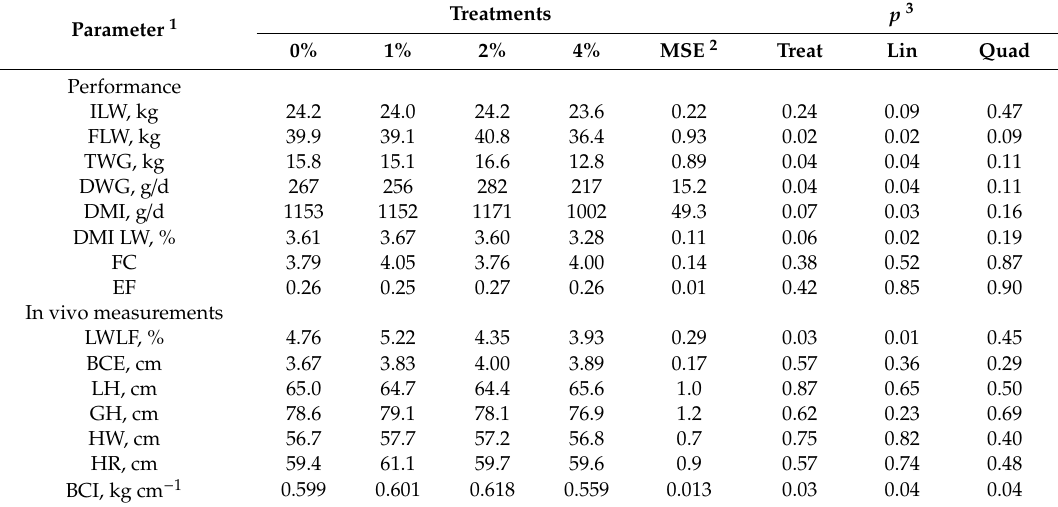
Table 4. Performance parameters and body morphometry of growing lambs fed increased levels of yerba mate extract. Parameter